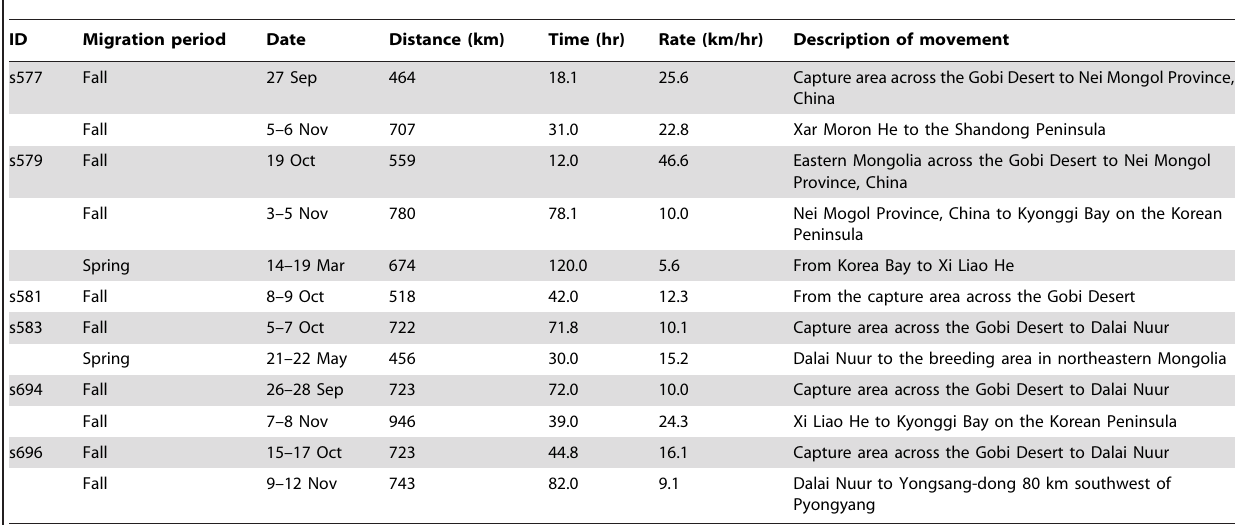
Table 3. Long distance migration movements recorded for whooper swans during fall 2006 and spring